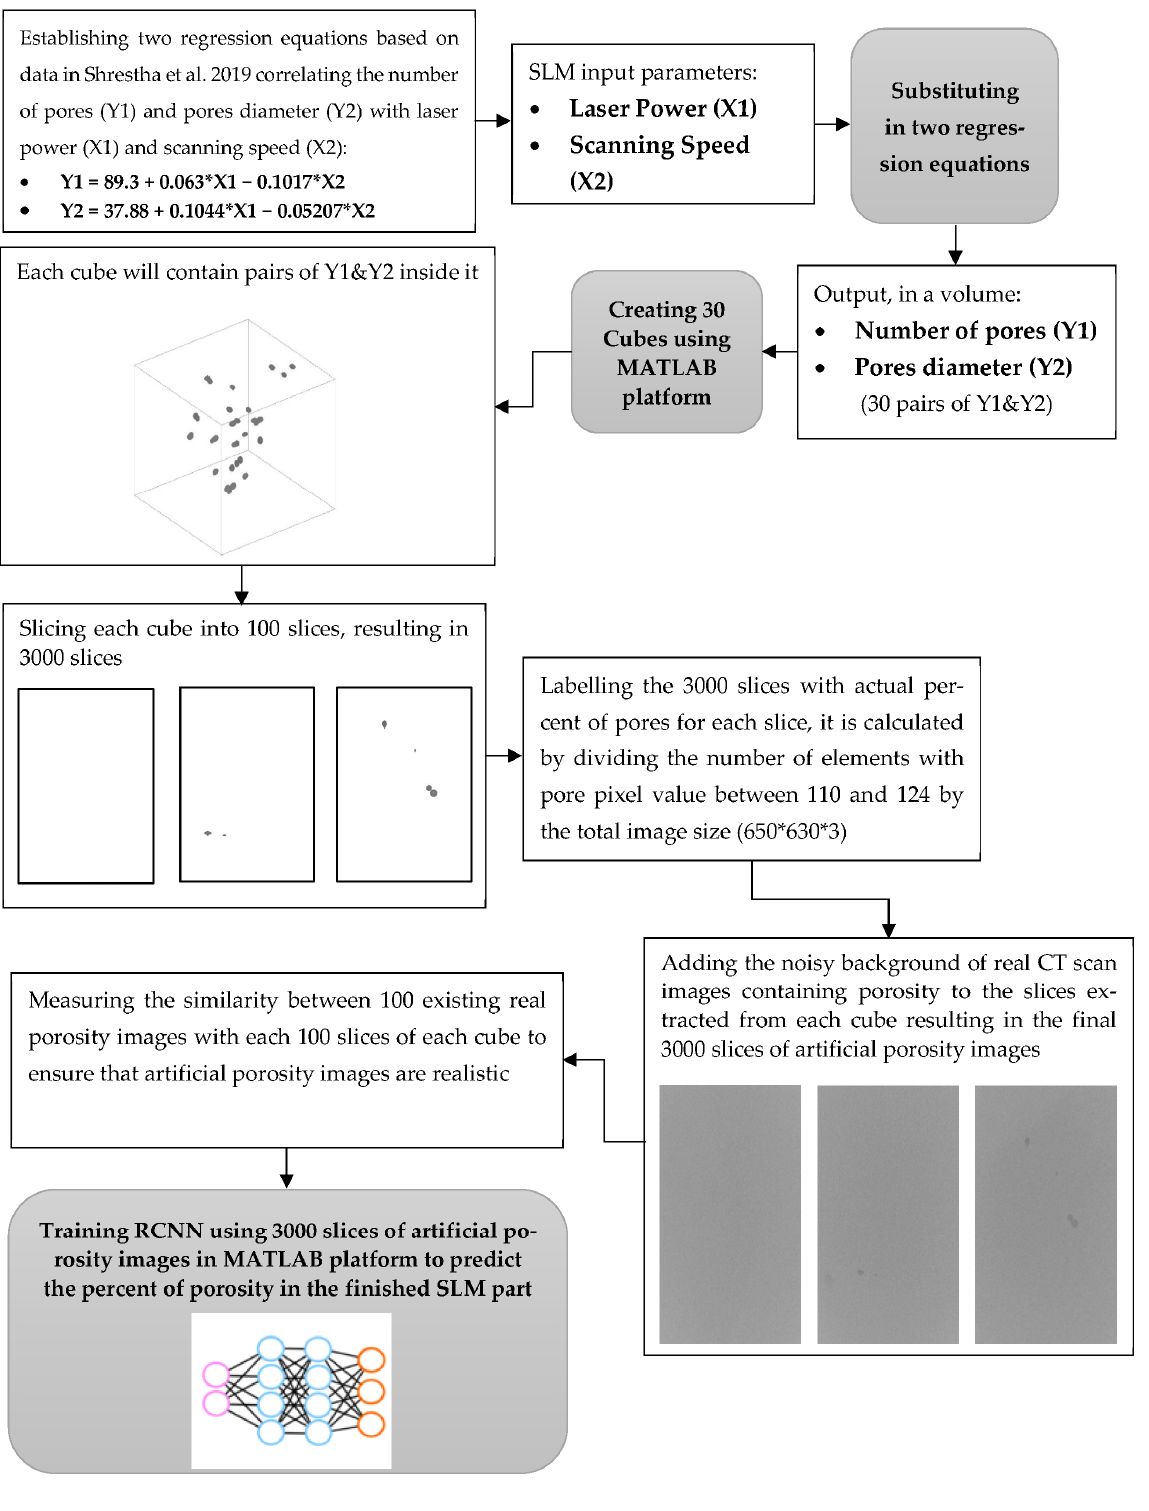
Figure 11. Flowchart for the steps of creating artificial porosity images [6].